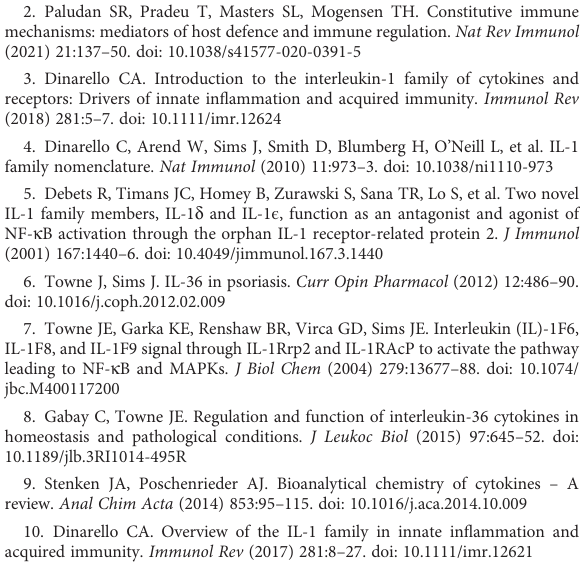
SUPPLEMENTARY FIGURE 1 (A) Microarray analysis from DSS-treated mouse colonic macrophages. (B) qPCR expression for P2x7r and Gsdmd in IC21 macrophages stimulated with LPS or LPS/ATP. (C) Densitometry of IL-36 g in macrophages under CTL, LPS/ATP or LPS/ATP+NSA